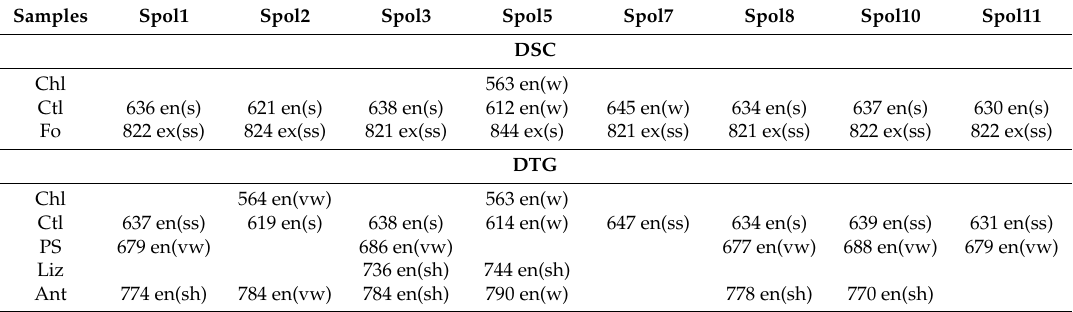
Table 2. Peak temperatures in DSC and DTG curves. W = weak, vw = very weak, s = strong, ss = very strong, sh = shoulder, en = endothermic, ex = exothermic.